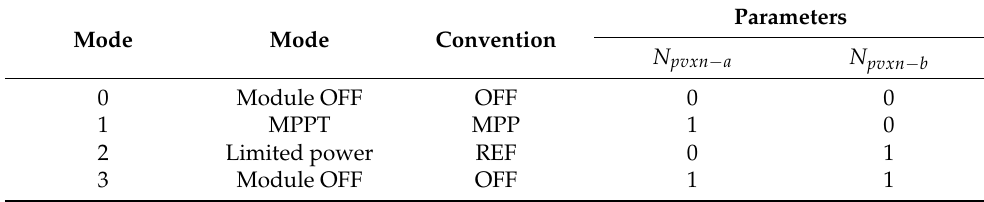
Table 1. Operation modes of PV